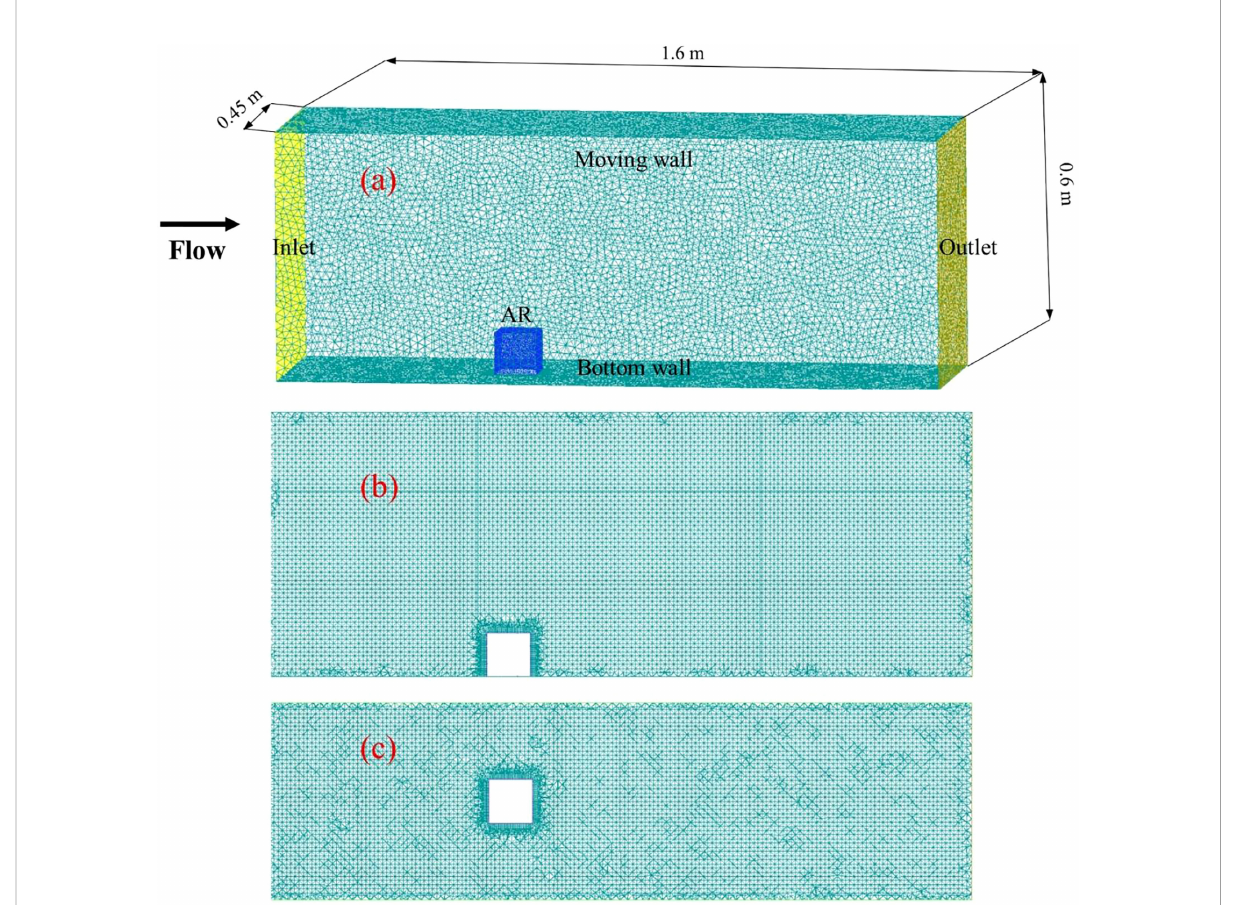
FIGURE 2 Schematic illustration of the grids in the computational domain; (A) 3D view; (B) Left view; (C) Top